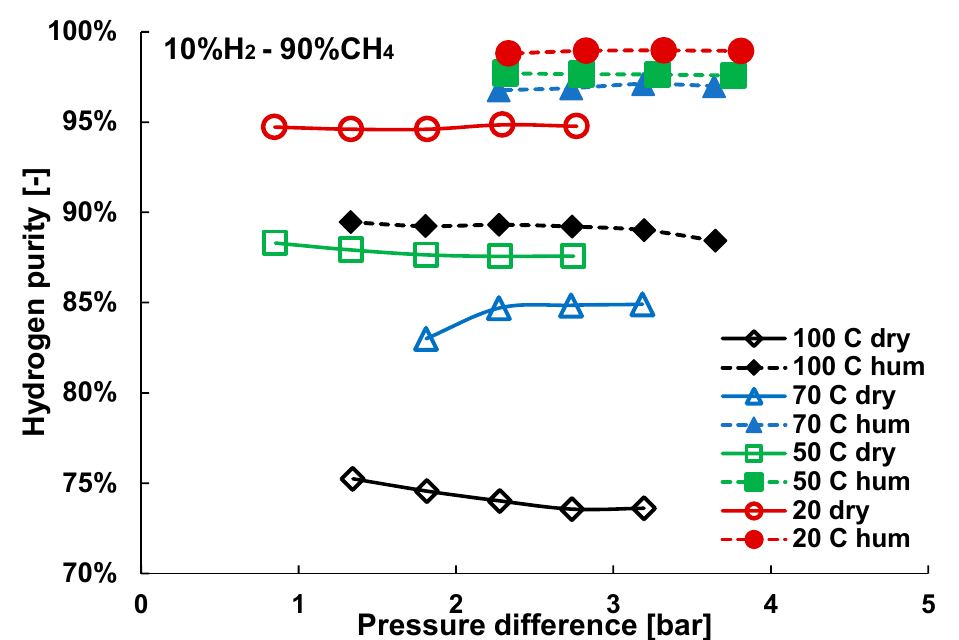
Figure 16. Comparison between hydrogen purity in an H 2 -CH 4 mixture with 10% hydrogen concentration at 20, 50, 70 and 100 °C in a dry and humidified membrane, for CMSM-600.